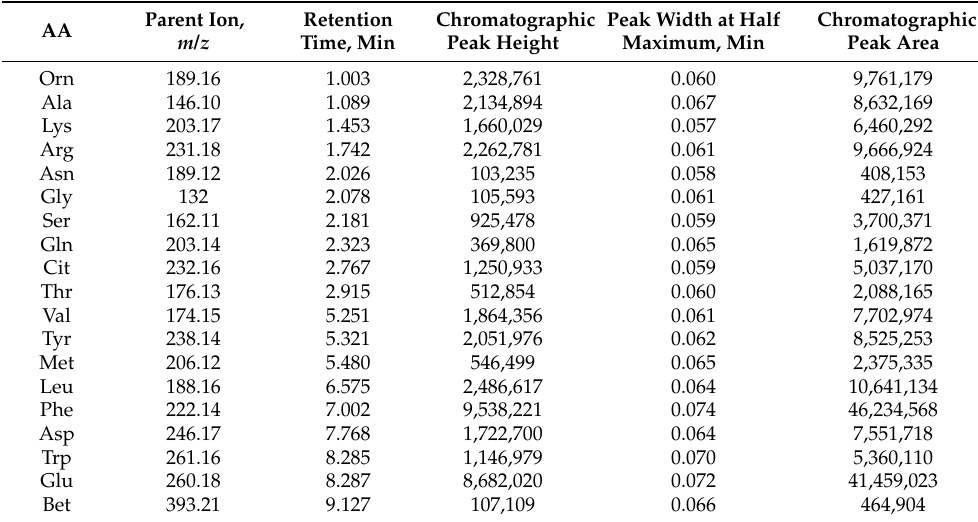
Table 6. Chromatographic mobility of esterified amino acids obtained using triple quadrupole MS. Amino acids are presented in ascending order of retention